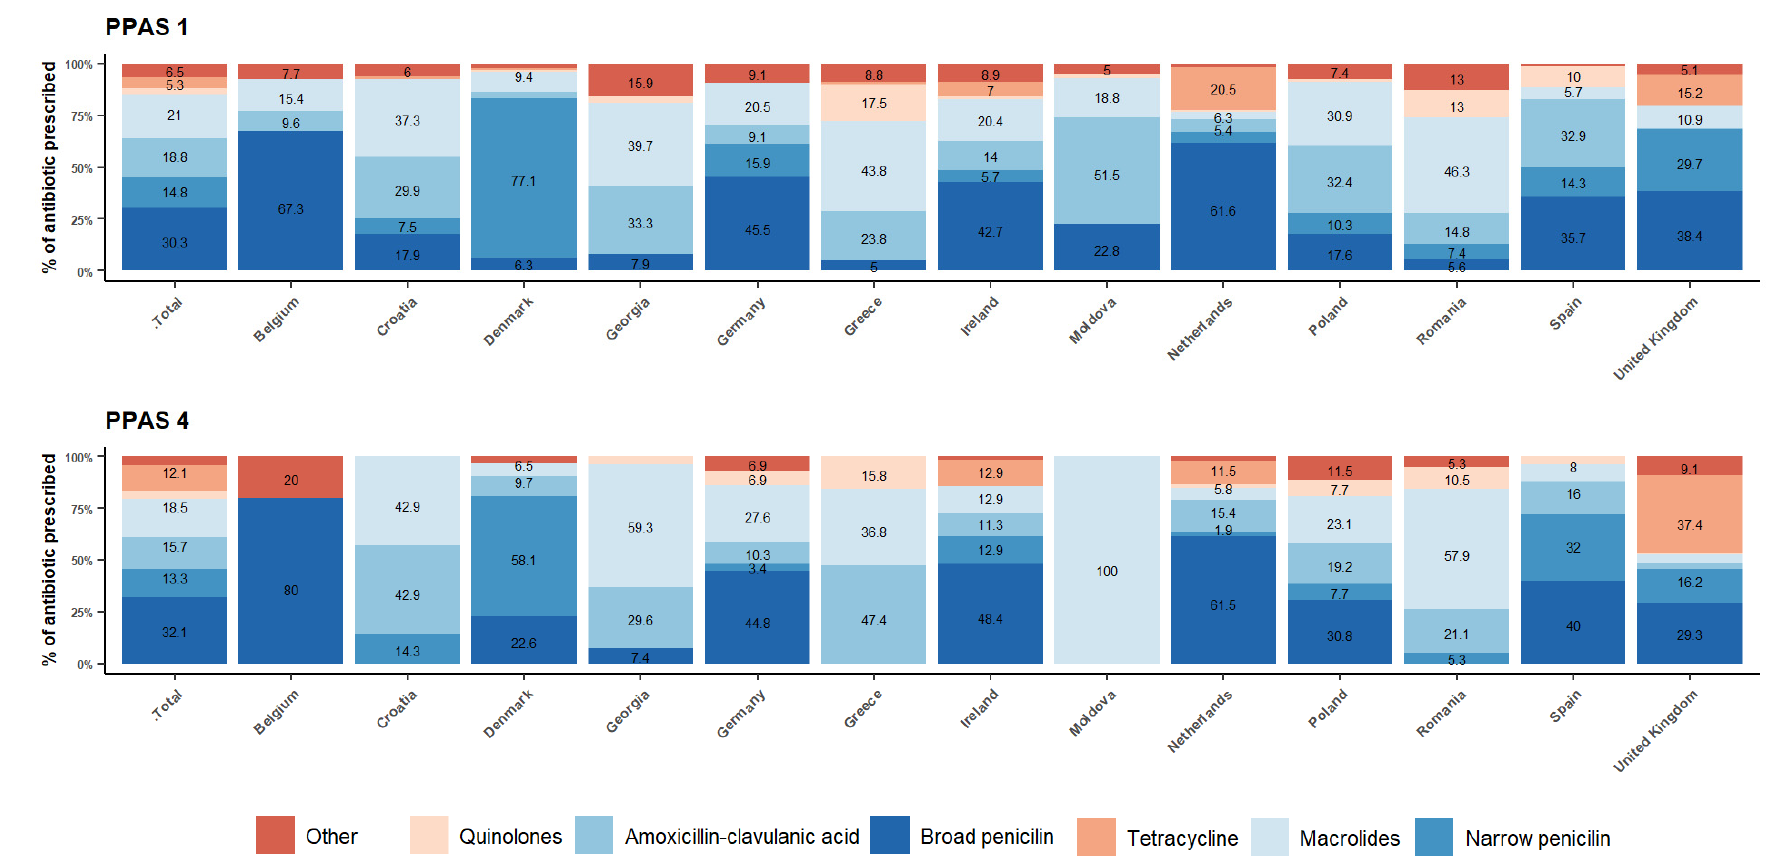
Figure 2. Overview of the percentage of each antibiotic prescribed, overall and by country in PPAS-1 and PPAS-4. Table 3. ESAC Quality Indicators by country for PPAS-1 (2020) and -4 (2022). Highlighted are the percentages that exceed the acceptable range for each QI.